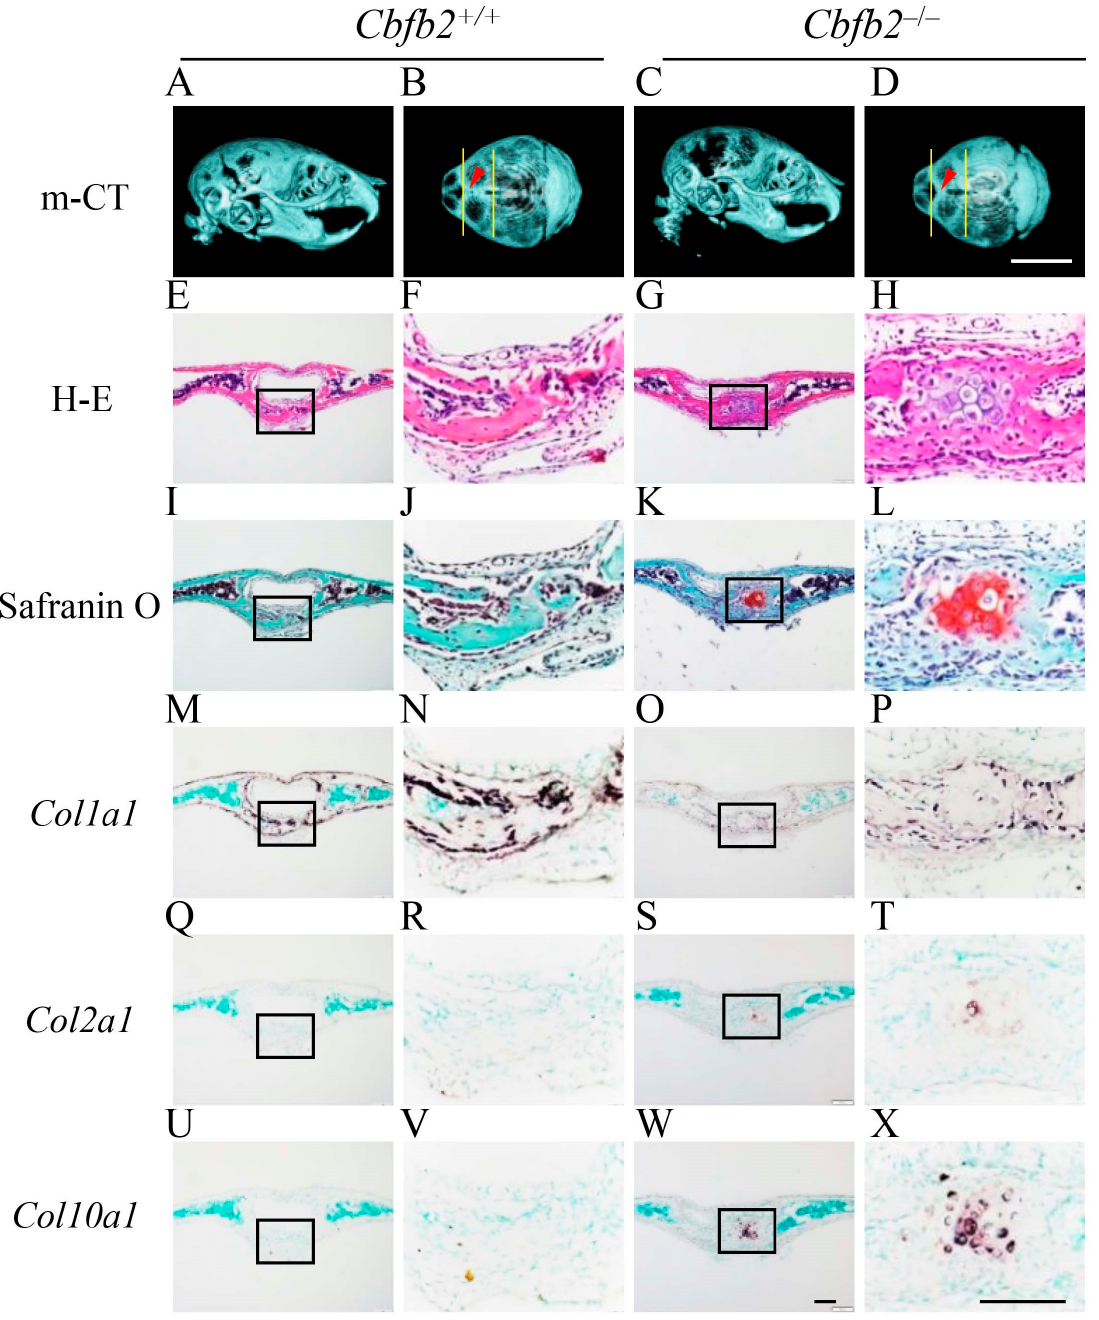
Figure 6. Micro-CT and histological analyses of posterior frontal sutures in Cbfb2 +/+ and Cbfb2 − / − mice at P14. ( A – D ) Lateral ( A , C ) and dorsal ( B , D ) views of micro-CT images of skulls. The two lines in ( B , D ) show the anterior and posterior boundaries of the posterior frontal suture, and arrow heads indicate the location of coronal sections in the histological analyses. ( E – H ) H-E staining. ( I – L ) Safranin O staining. ( M – X ) In-situ hybridization using a Col1a1 ( M – P ), Col2a1 ( Q – T ) and Col10a1 ( U – X ) probes. The boxed regions in the left columns were magnified in the right columns. Scale bars: 0.5 cm ( A – D ) and 100 µ m ( E – X ). Three Cbfb2 +/+ mice and two Cbfb2 − / − mice were analyzed.